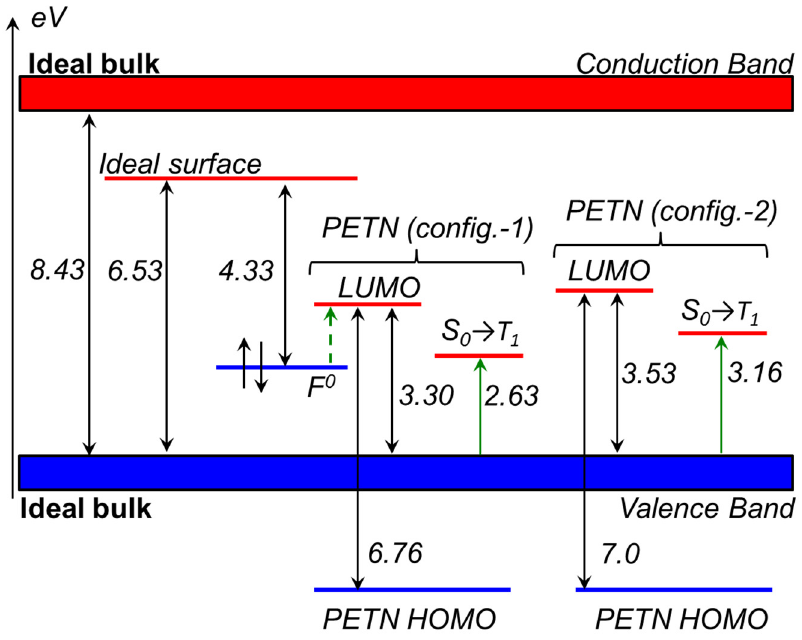
Figure 2. The relative energies of the (0001) α -Al 2 O 3 surface, F 0 -center, and PETN- induced electronic states in the bulk band gap are shown. The dashed green arrow indicates the predicted F 0 -center (HOMO) → PETN (LUMO) transition with the energy of 1.2 eV. The solid green arrows correspond to singlet-triplet excitations from the aluminum oxide surface to PETN.